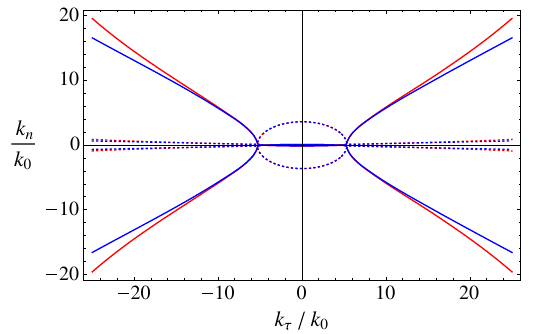
FIG. 5. The isofrequency plot of the semiconductor hyperbolic metamaterial, used in the hypercrystal from Fig. 4, for the free-space wavelength λ ¼ 10 μ m (or equivalently the frequency ω ¼ 1000 cm − 1 ). The metamaterial unit cell is formed by 50-nm-wide layers of insulating Al 0 In 0 Ga 0 As (with the plasma frequency λ . 53 . 47 blue colors correspond to the exact solution and the effective medium approximation, respectively. Solid curves represent the real part of the normal to the layer component of the wave vector k , while the dotted lines show Im ½ k n